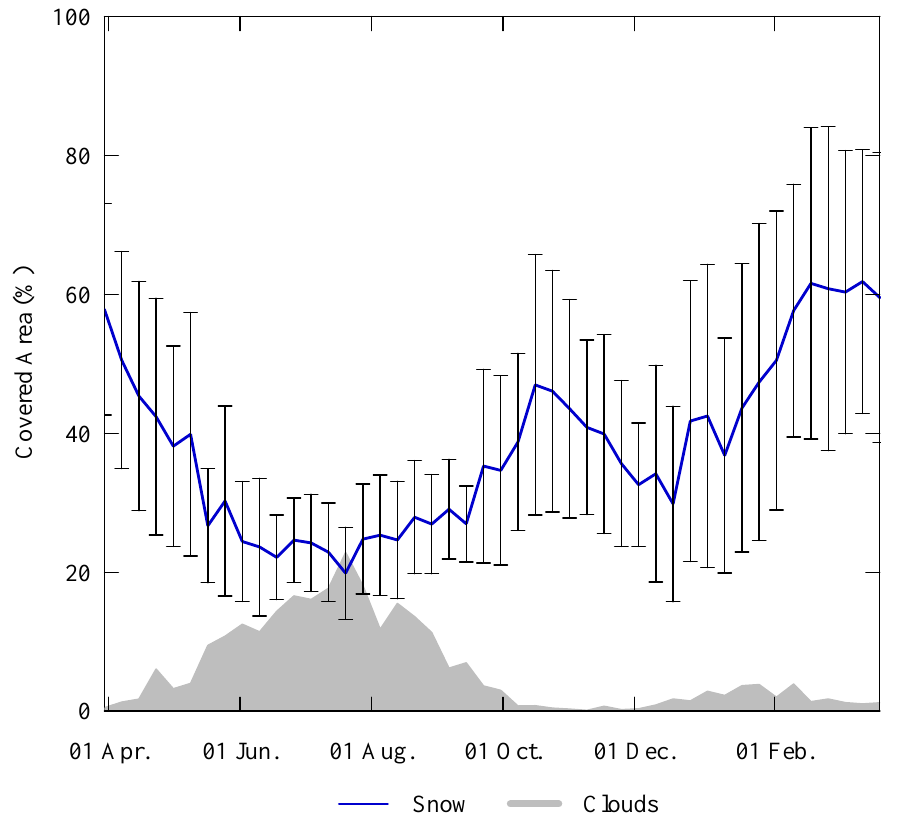
Figure 7. Intra-annual variation of 8-day synthesis of snow cover and cloud coverage in the Phakding basin (mean values 1998–2017). The standard deviation of the snow cover area between the years is also presented.